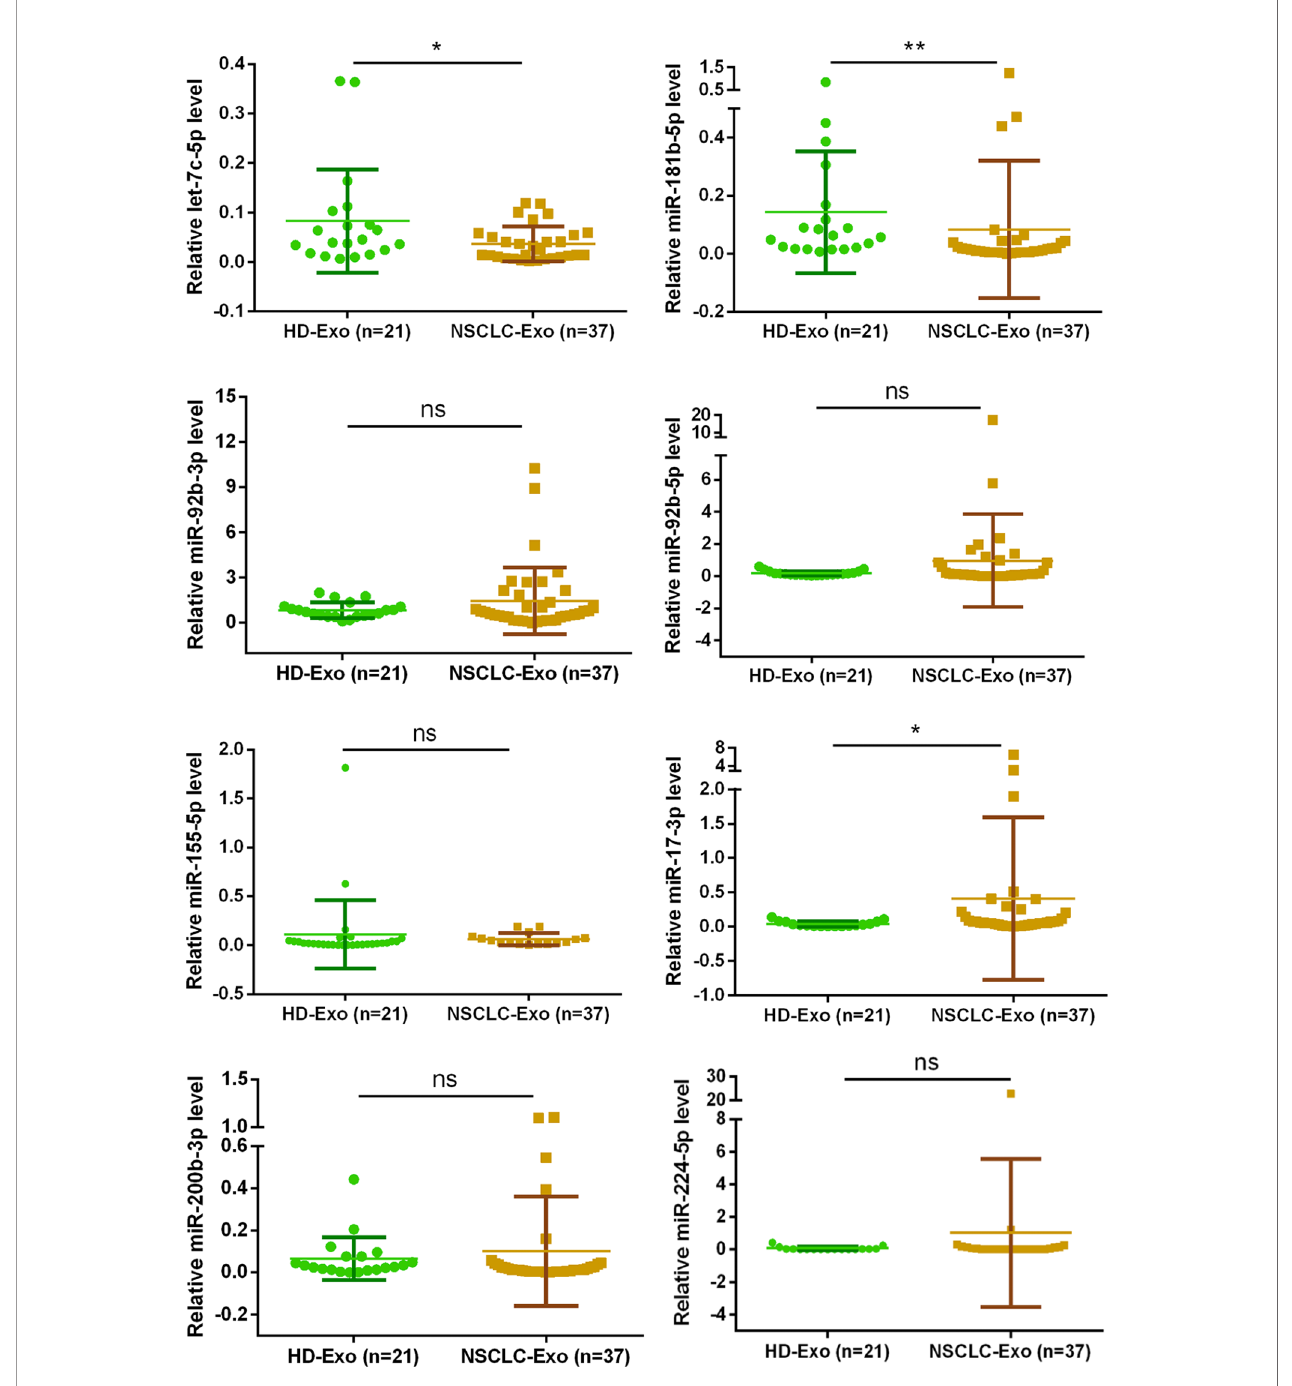
FIGURE 4 | The exosomal miRNA expression in 21 normal persons and 37 NSCLC patients. RT-qPCR was utilized to compare the exosomal miRNA expression level of let-7c-5p, miR-17-3p, miR-92b-3p, miR-92b-5p, miR-155-5p, miR-181b-5p, miR-200b-3p, and miR-224-5p from the serum of healthy controls (n=21) and NSCLC patients (n=37). Non-parametric test was adopted to analyze the differences between groups; ns, no signi fi cance; * p <0.05, ** p <0.01, and n ≥ 3.